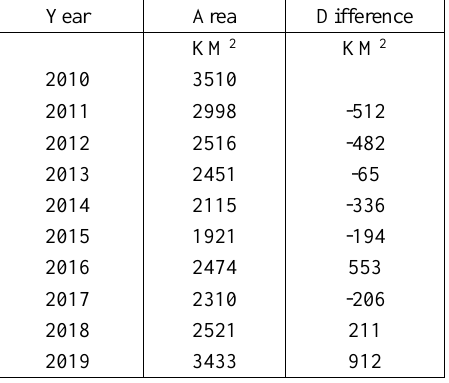
Table 3. Diversity of water level compared previous year after applying